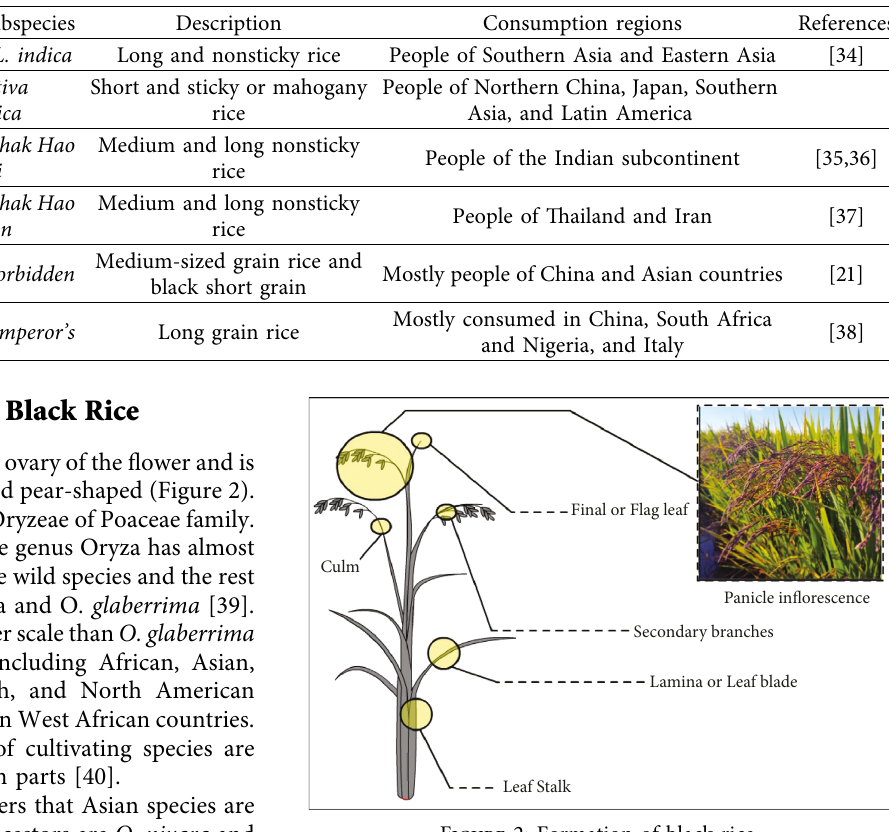
Table 1: Different classification of black rice consumption in the different regions of the world.